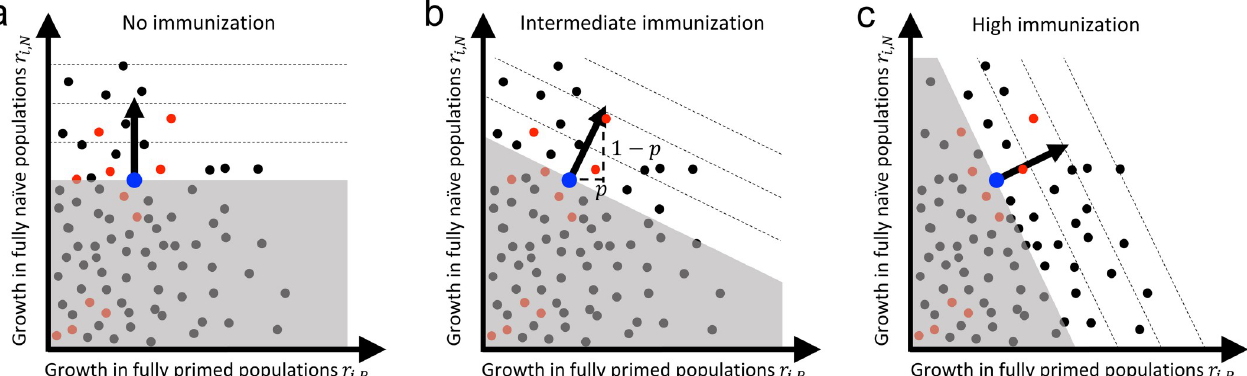
Fig 3. Selection and genetic variation. Plots of the growth rate of all viable variants ( i ) in a fully na ï ve and a fully primed population (black dots). Large blue dot denotes the current wild type. Red dots are those variants that are most accessible from the wild type. Note that the location of all variants along the r i , P axis is specific to an immune response and may be different for natural immunity and different vaccines. All variants in the white region are selectively advantageous but variants in the direction of the selection arrow are most strongly favored (dashed lines indicate contours of overall growth rate). Variants in the gray region are disfavored by selection. The direction of selection arrow is upwards in a fully na ï ve population ( p = 0) (panel ( a )) and shifts towards the right as the fraction of primed individuals increases (panels ( b and c